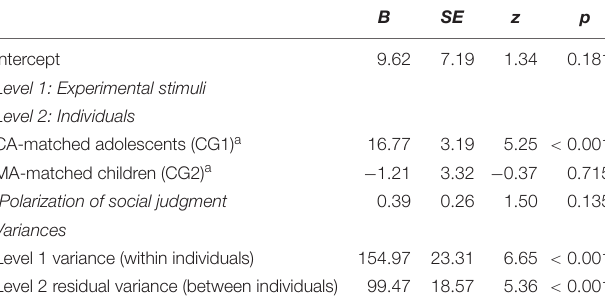
TABLE 5 | Means-as-outcomes-model: Effect of polarization on susceptibility to ingroup influence ( N =